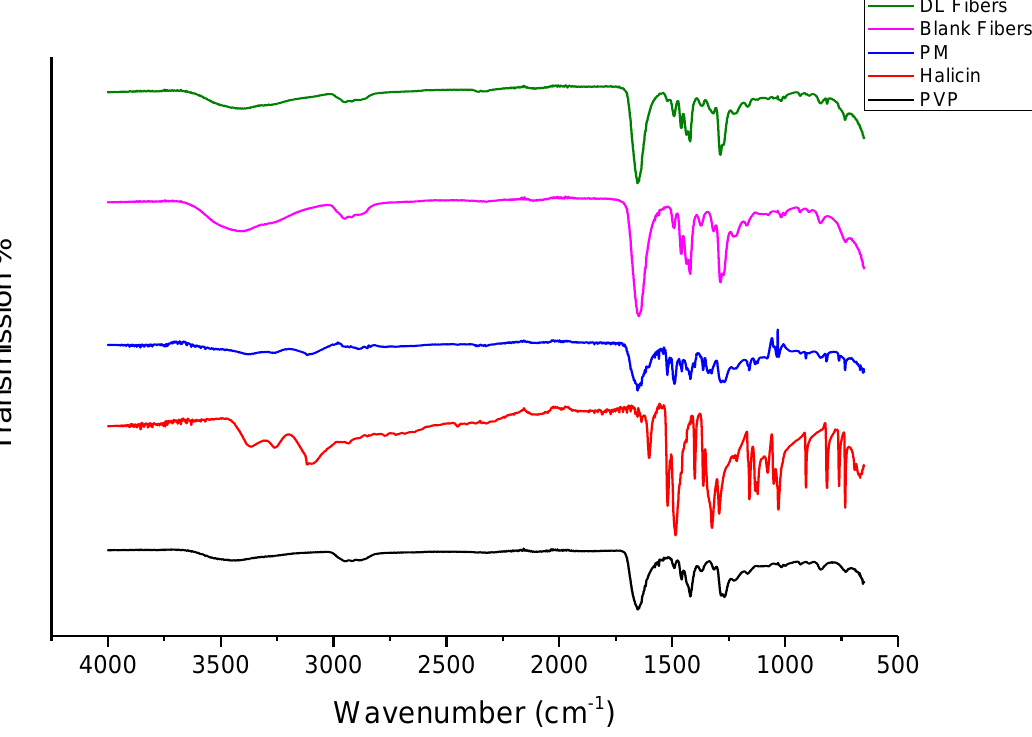
Figure 3. Fourier-transform infrared spectroscopy (FTIR) transmissions of polyvinylpyrrolidone (PVP), halicin, physical mixture (PM), blank and drug-loaded fibers, showing the distinctive drug peaks at 761 to 734 cm −1 that appear in the PM and the drug-loaded fibers compared to the blank fibers.